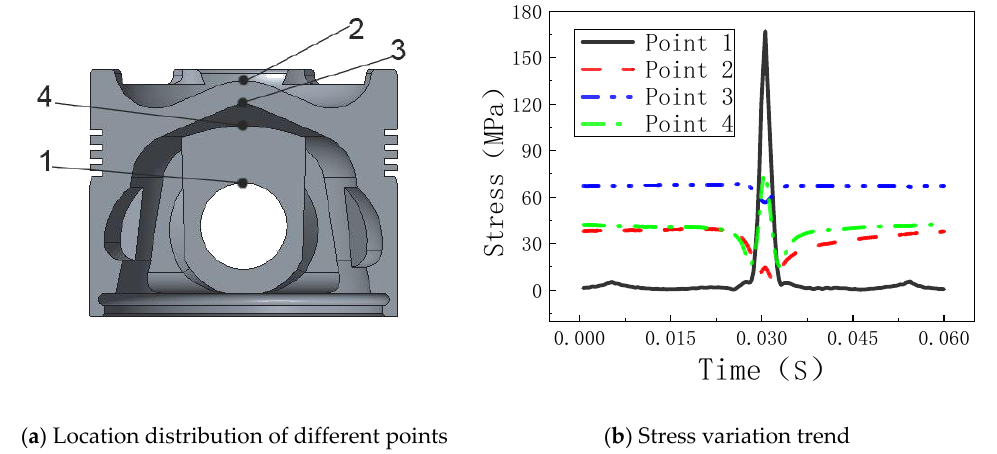
Figure 5. Change rule of the coupling stresses at different points in the piston with time. ( a ) Location distribution of different points; ( b ) Stress variation trend.